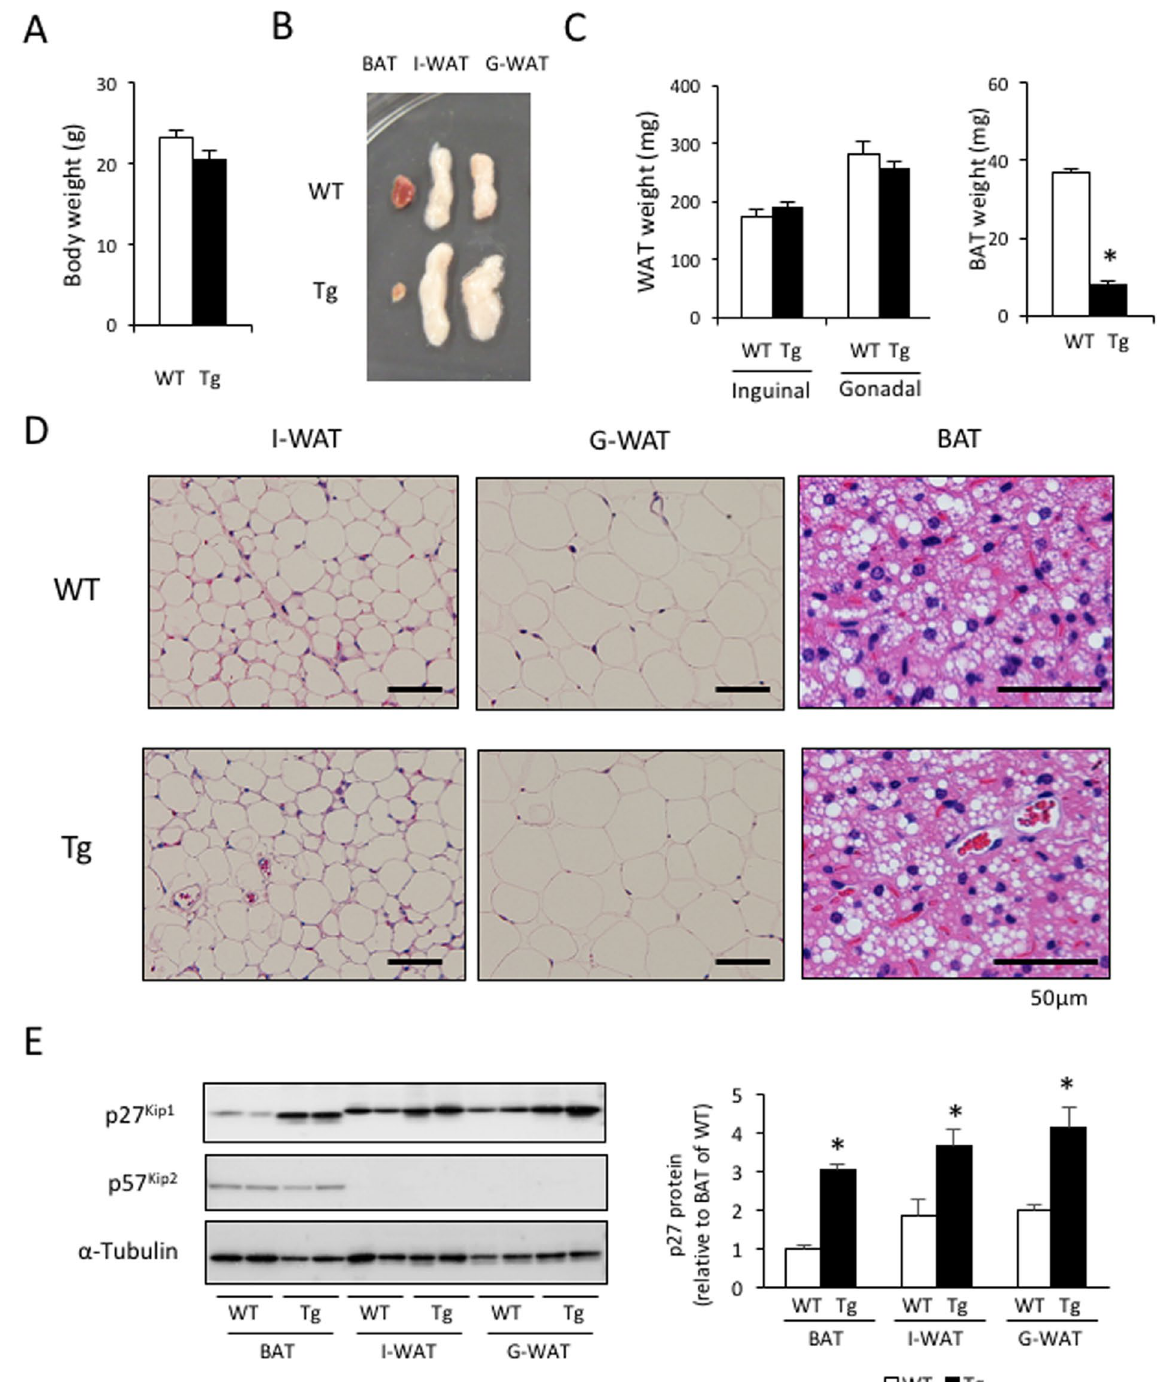
Figure 1. Transgenic expression of p27 driven by the aP2 promoter did not affect WAT development but suppressed BAT development. ( A ) There were no differences in body weight between 12-week-old WT and aP2-p27 Tg mice. ( B – D ) Tissue weights ( C ) and representative examples of the gross ( B ) and histological ( D ) appearance show that inguinal and peri-gonadal WAT (I-WAT and G-WAT) in Tg mice is highly similar to I-WAT and G-WAT in WT mice. Conversely, interscapular BAT in Tg mice was reduced in size and volume but had normal histological features, compared to BAT in WT mice (n = 5 per group, Student’s t-test, * p < 0.05). ( E ) Measurement of the expression of p27 Kip1 and p57 Kip2 proteins showed the induction of p27 protein in the fat tissue of Tg mice (n = 5 per group, Student’s t-test, * p <